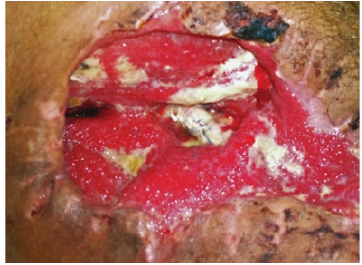
Figure 3: PTFE patch wrapped around the arterial graft to secure the anastomosis. Notice the granulated tissue in secondary